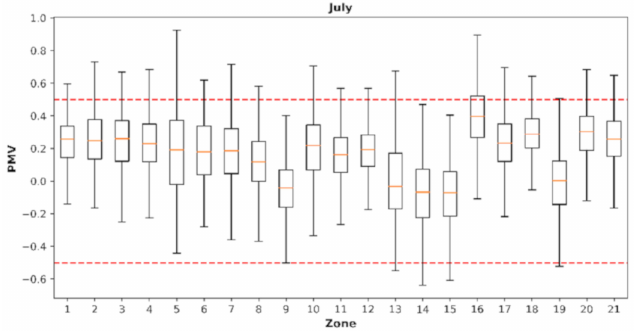
Figure A12. PMV in